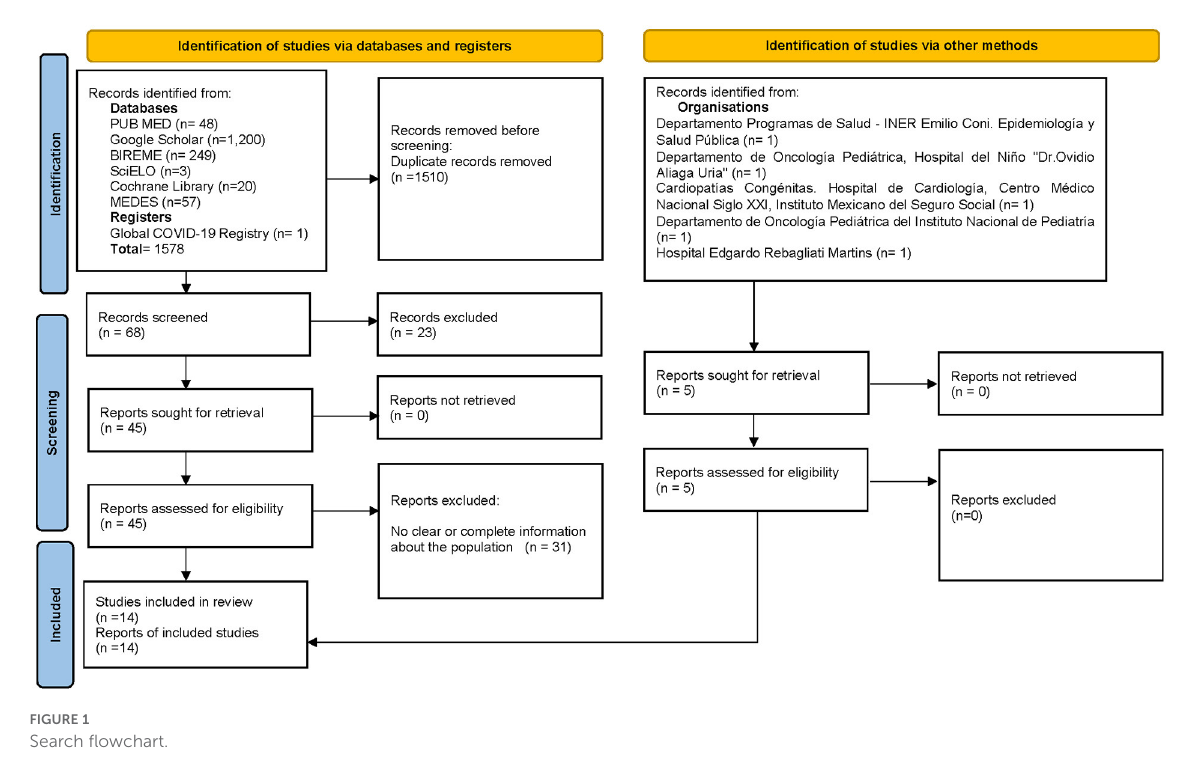
FIGURE1 Search flowchart.